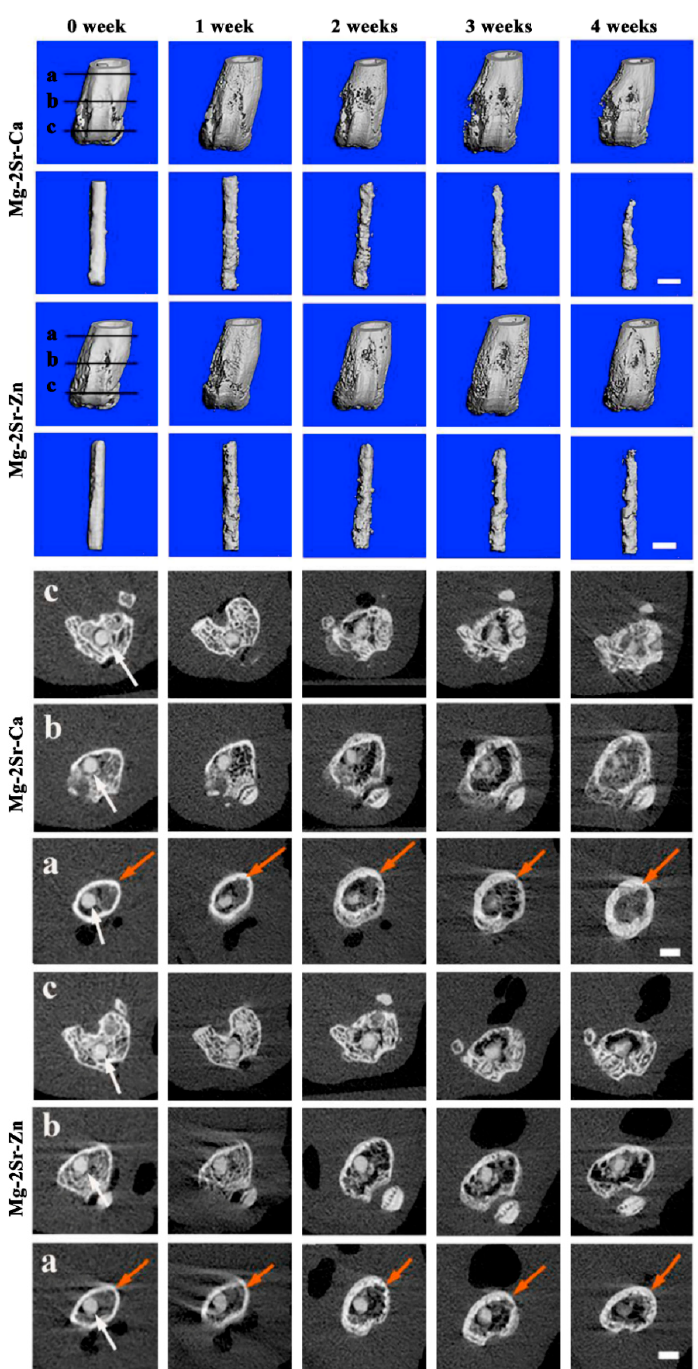
Figure 1. Three-dimensional reconstruction of the femora of mice, intramedullary Mg–2Sr–Zn and Mg–2Sr–Ca pins and two-dimensional cross-sectional images of the femora of mice in various places after surgery, corresponding to the straight black lines with embedded Mg–2Sr–Zn and Mg–2Sr–Ca pins (white arrows) at various post-operation time points. ( a ) The proximal part of the distal femur, ( b ) middle part of the distal femur, and ( c ) distal part of the distal femur. The bar length is 1.0 mm. As is indicated, localized degradation of the bio-materials at the surface of the rod can be seen in both trabecular and cortical bone regions one week after implantation. In the bone-marrow-cavity area, more rapid degradation was found in comparison with the distal areas, and the in vivo degradation of Mg–2Sr–Ca alloy rods was faster than that of Mg–2Sr–Zn alloy rods. Reprinted with permission from Ref. [156]. Copyright 2020, KeAi.